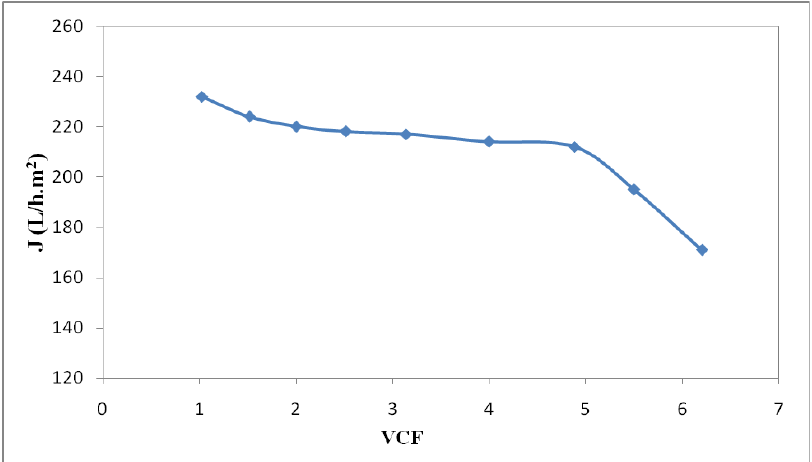
Figure 8. Evolution of permeate flux versus VCF at optimized conditions of treatment: C oil of 117 g/L, T = 60°C, and Δ P = 3.5 bar.